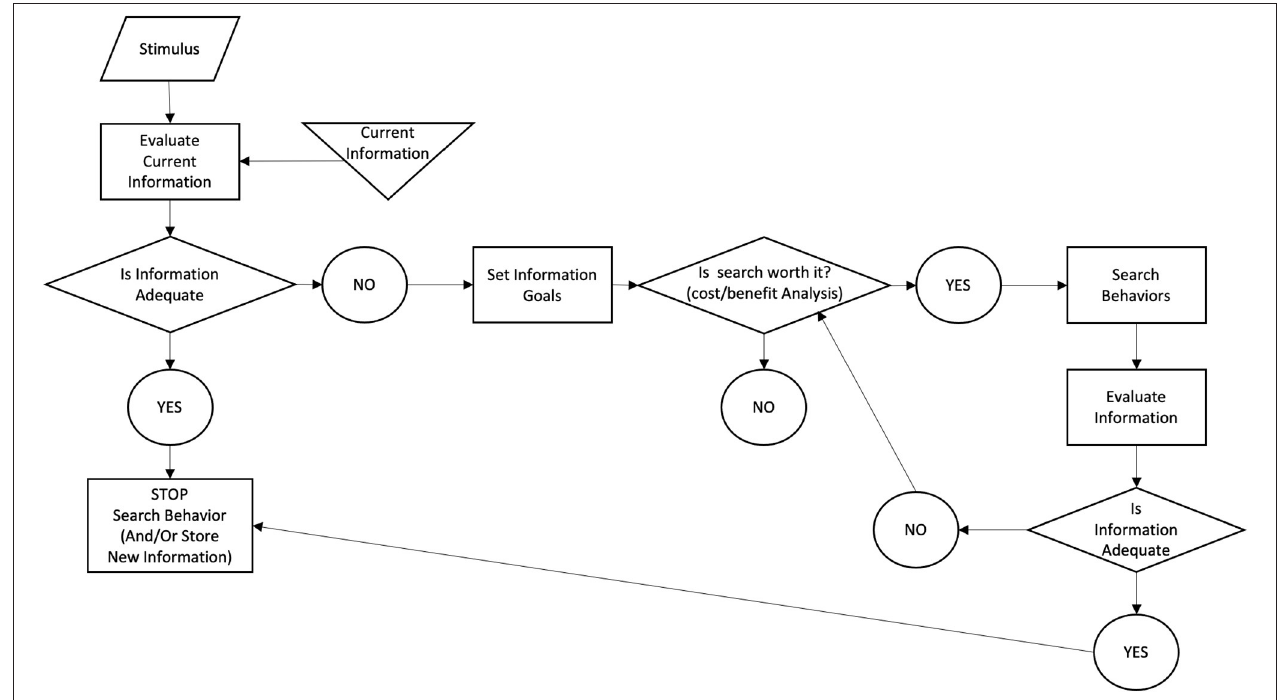
FIGURE 5 | Freimuth’s health information collection